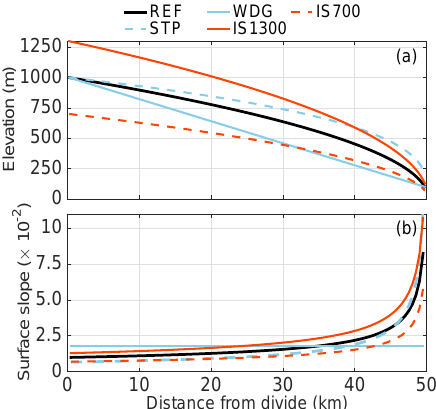
Figure 1. (a) Different ice geometries considered (see Tables 3 and 4) and (b) corresponding ice-surface slopes. The geometries REF, IS1300, and IS700 are parabolas such that the surface el- √ x , where z s , max is the max- evation is given by z s ( x ) = z s , max imum ice-surface elevation and x ∈ [ 1 , 0 ] . In order to obtain the steeper front in STP we use a cubic root instead of the square root: z s ( x ) = z s , max x 1 / 3 . The wedge-like geometry WDG is defined by a straight line with the same elevation change as